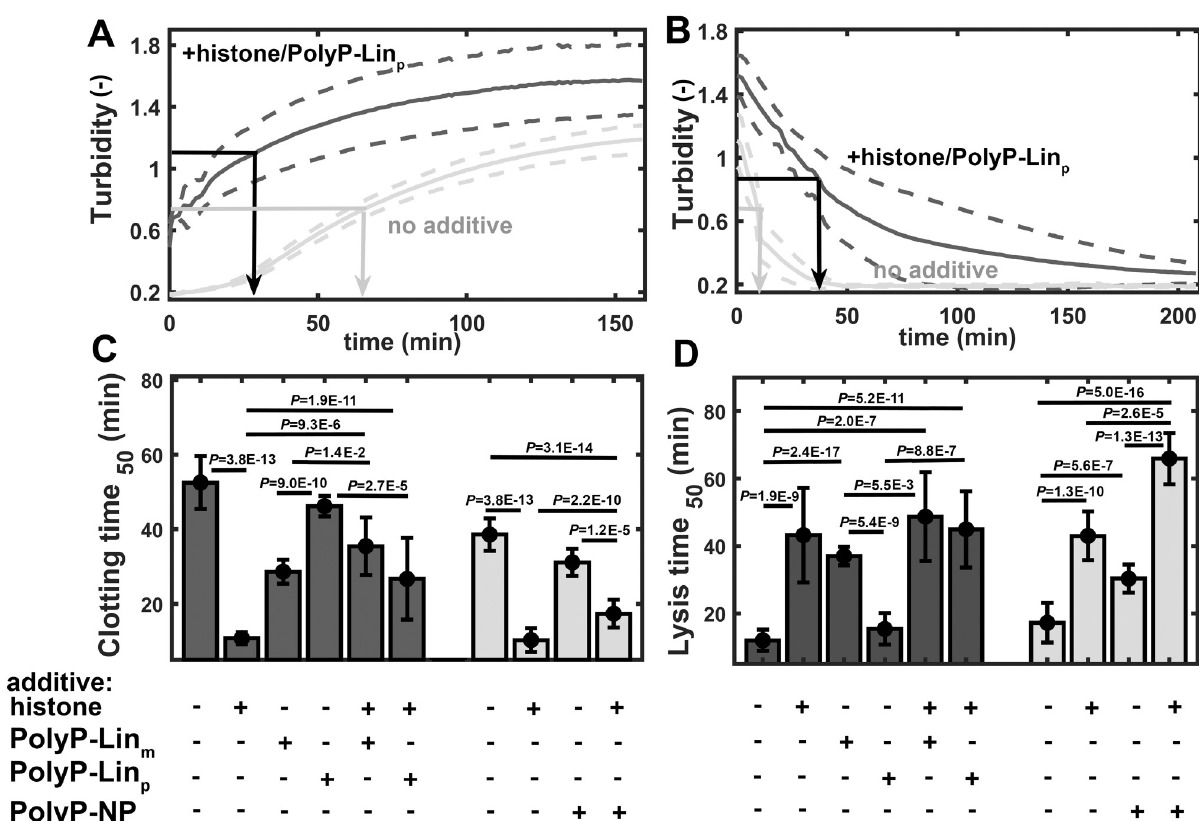
Fig 4. Combined effects of histone and polyphosphates on fibrin formation and lysis. Fibrinogen (7 μ M) mixed with plasminogen (0.2 μ M) was clotted by thrombin (2 nM) in the presence or absence of histone (20 μ M), linear PolyP-Lin m (330 μ M), linear PolyP-Lin p (1.96 × 10 12 particle/l equivalent to 330 μ M) or nanoparticulate (1.96 × 10 12 particle/l) polyphosphate and the absorbance at 340 nm (Turbidity) was measured (Panel A). At plateau phase tPA (140 nM) was layered on the surface of clots and measurement was continued until complete lysis (Panel B). Arrows indicate the time to reach half-maximal turbidity (clotting time 50 and lysis time 50 ) in the ascending and descending phase of the representative turbidimetric curves in panels A and B, respectively. Median values and interquartile range (error bars) of clotting time 50 (Panel C) and lysis time 50 (Panel D) are shown in black (no Ca 2+ ) or grey (1.67 mM Ca 2+ ). P -values for differences of the indicated pairs of datasets are shown according to Kolmogorov-Smirnov test (n = 15).